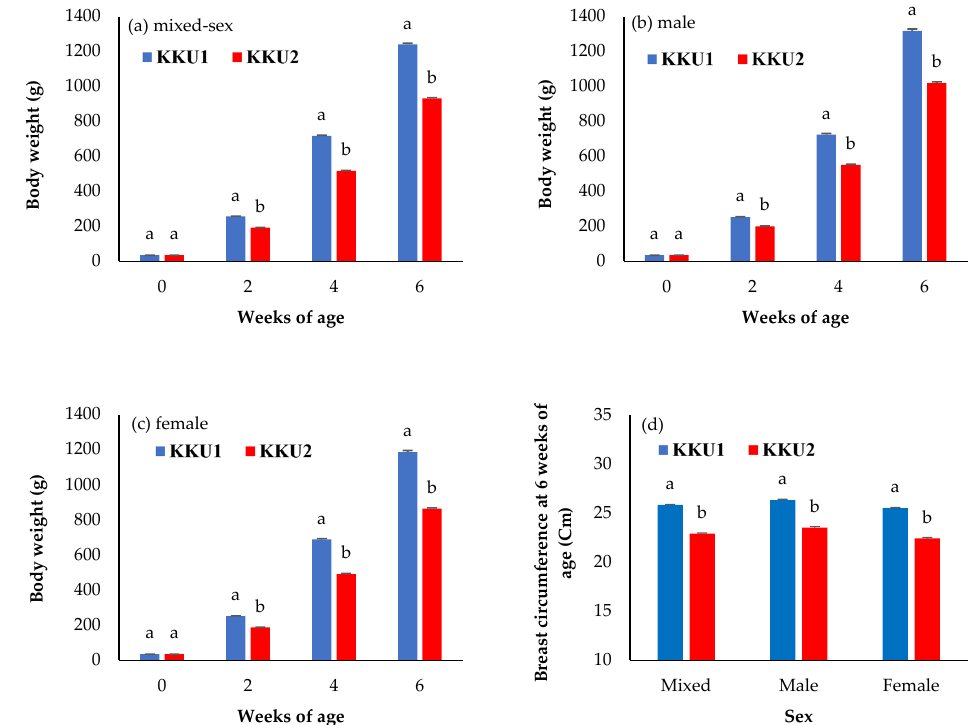
Figure 1. Least square means ± standard error of ( a ) the body weight of the mixed-sex chickens (birth weight (0), 2, 4, and 6 weeks of age), ( b ) body weight of the males (birth weight (0), 2, 4, and 6 weeks of age), ( c ) body weight of the females (birth weight (0), 2, 4, and 6 weeks of age), and ( d ) breast circumference at 6 weeks of age of the mixed-sex, male, and female chickens. KKU1 = crossbred chicken between commercial broiler and Thai indigenous synthetic chickens (Kaimook e-san1); KKU2 = crossbred chicken between Kaimook e-san2 and Kaimook e-san1 (both of which are Thai indigenous synthetic chickens). Means for the same trait with different letters ( a,b ) differ significantly ( p < 0.05).